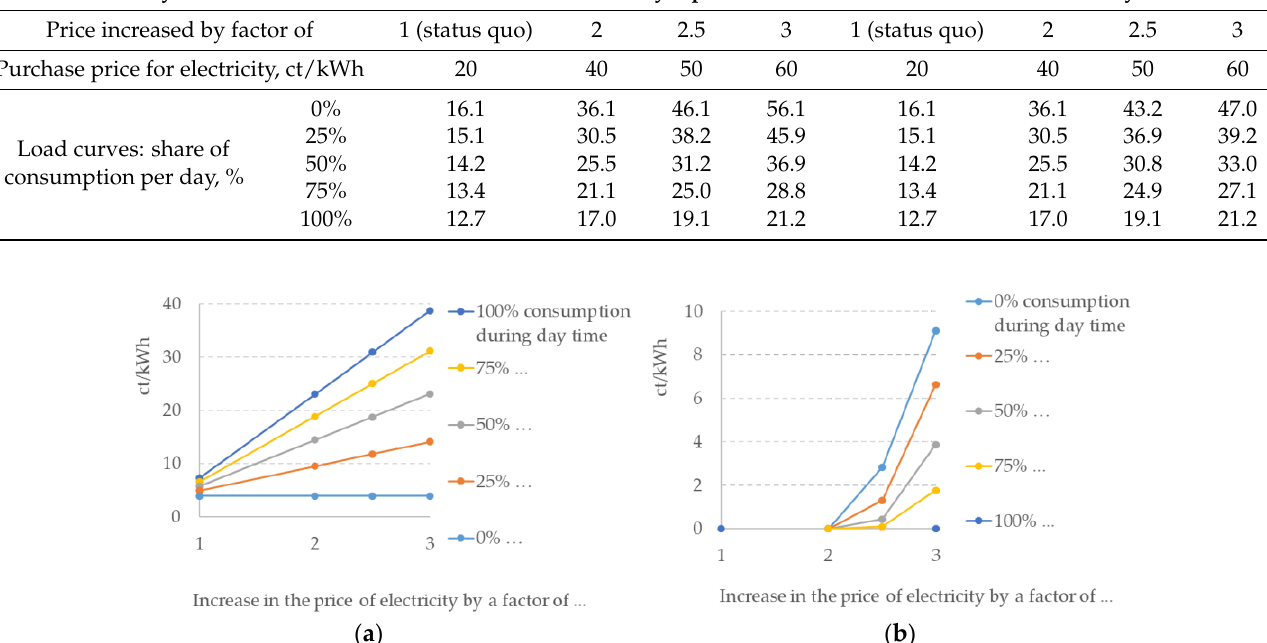
Figure 11. ( a ) Economic advantages of investing in a PV system for a farm’s power supply and ( b ) additional benefits of investing in batteries.